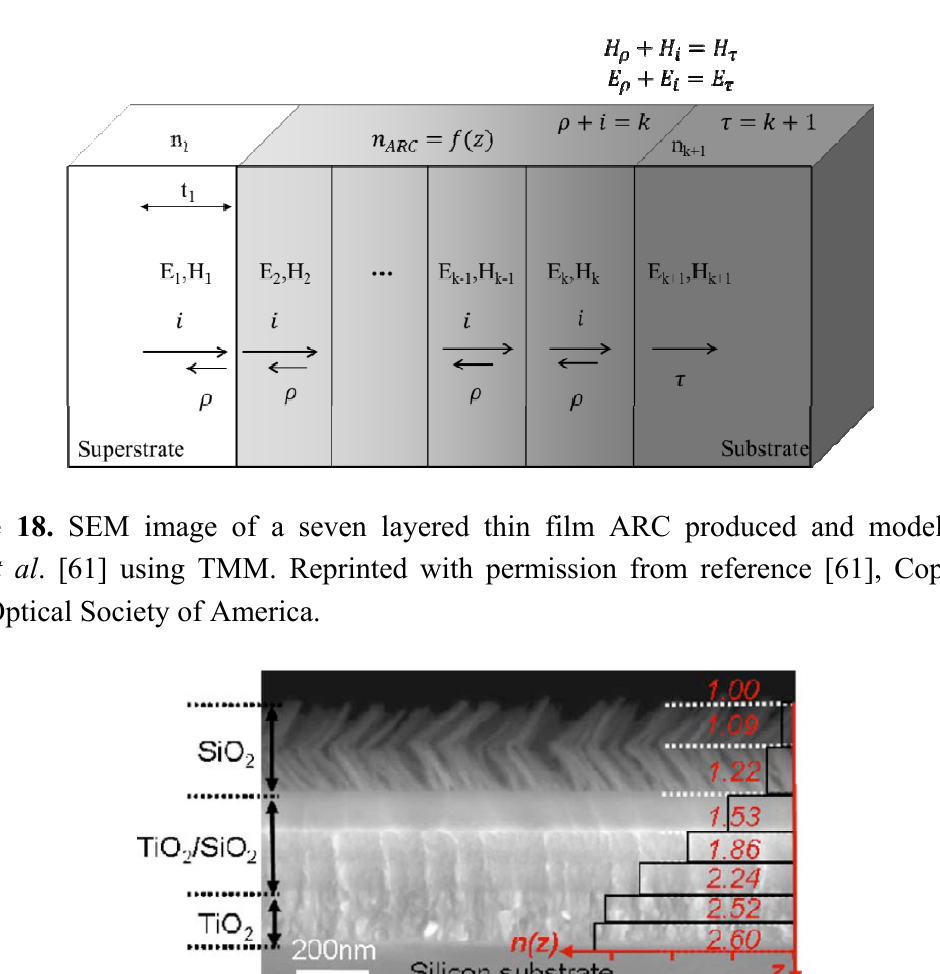
Figure 17. Geometry of the transfer matrix method. Each layer left to right represents a separate, homogeneous material. H is the magnetic field and E is the electric field. The thickness, t , of each layer is drawn. The RI is labeled as n , reflected wave energy as ρ , transmitted energy as τ , and k is a designation of layer position (this diagram includes layers 1 through k + 1).